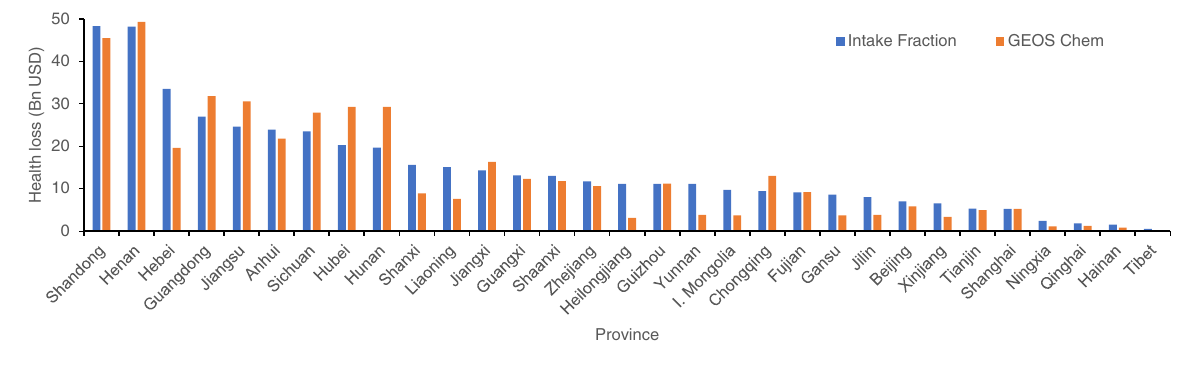
Fig. 6 Values of provincial health losses in 2017 based on intake fractions (IF) model and GEOS-Chem model. IF model results have higher values in remote regions, such as Heilongjiang, Inner Mongolia, Yunnan, and Tibet, while the GEOS-Chem model results have higher values in central provinces, such as Hubei, Hunan,